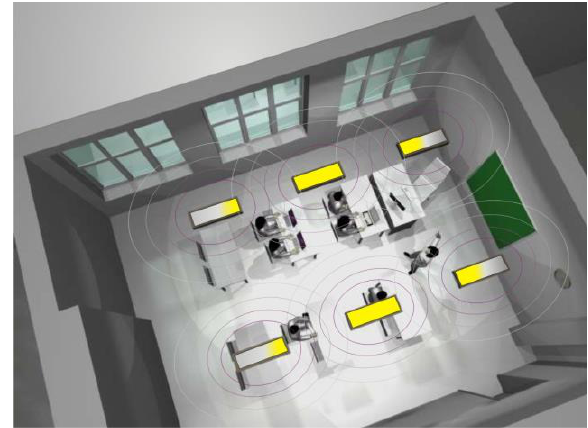
Fig. 1. General idea of the intelligent luminaire system [source: own